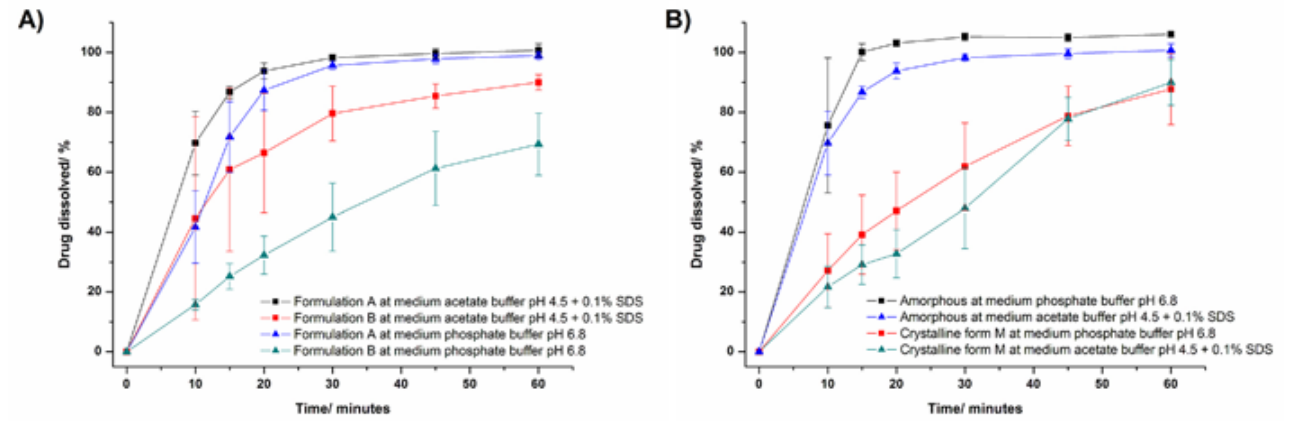
FIGURE 7 - Dissolution profiles of ROSC capsules from different media using basket at 100 rpm